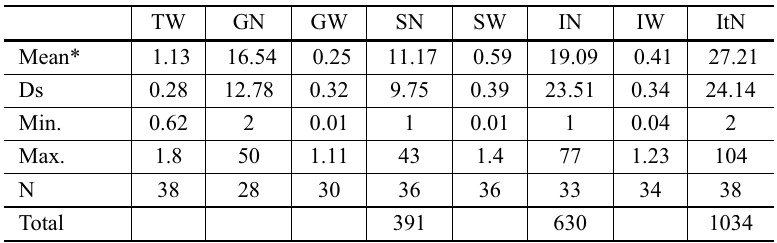
Mean winter dietary item values of Embernagra platensis at the Laguna de Guaminí during July 2000 (Montalti et al. 2005).